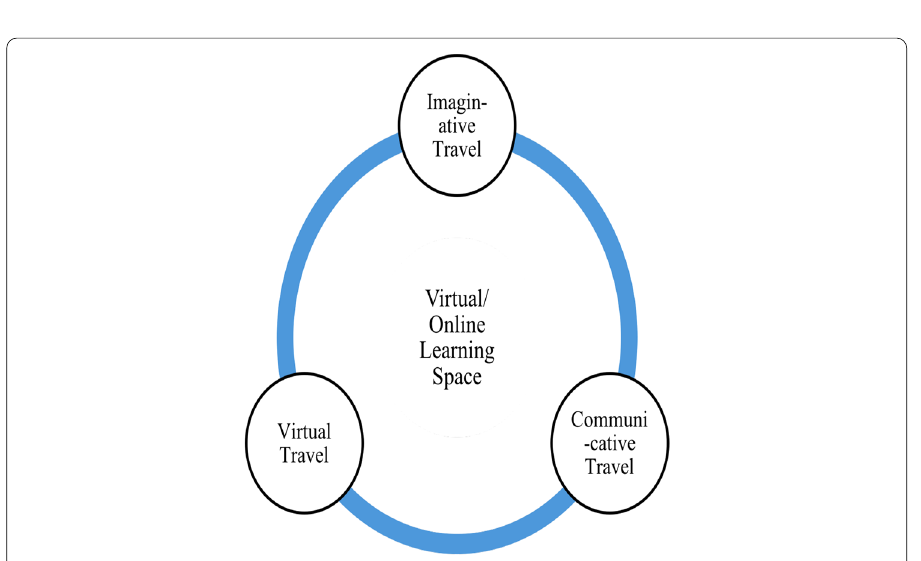
Fig. 3 Mobility in virtual learning